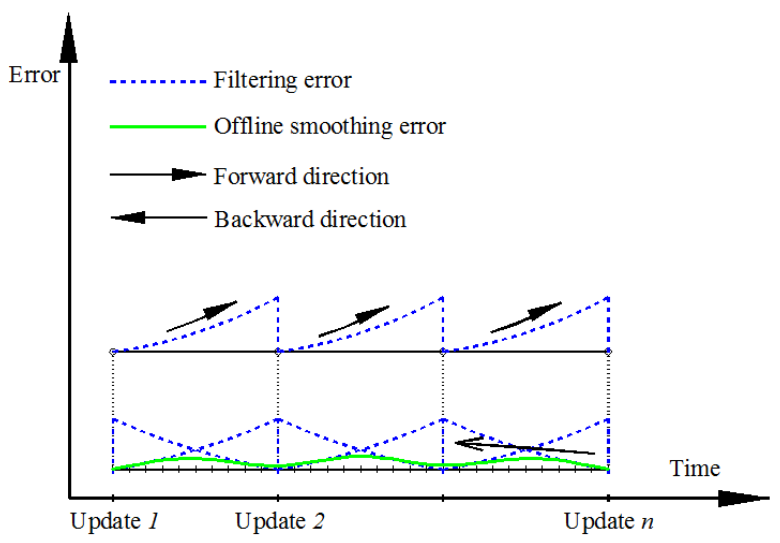
Figure 1. Process and performance of off-line smoothing.